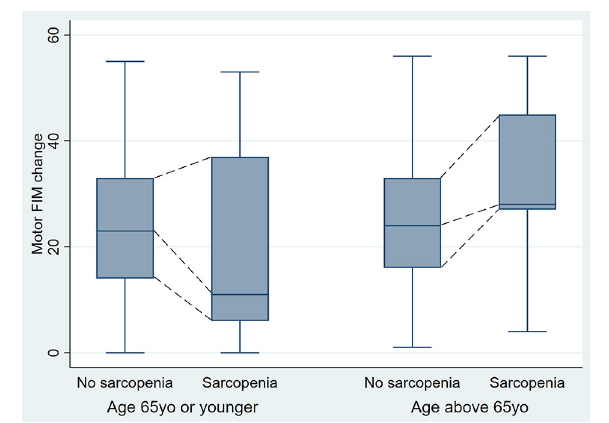
FIGURE 3 | Motor FIM change in younger and older participants by sarcopenia status (One outlier value was removed from the Figure for ease of interpretation, but was still included in the